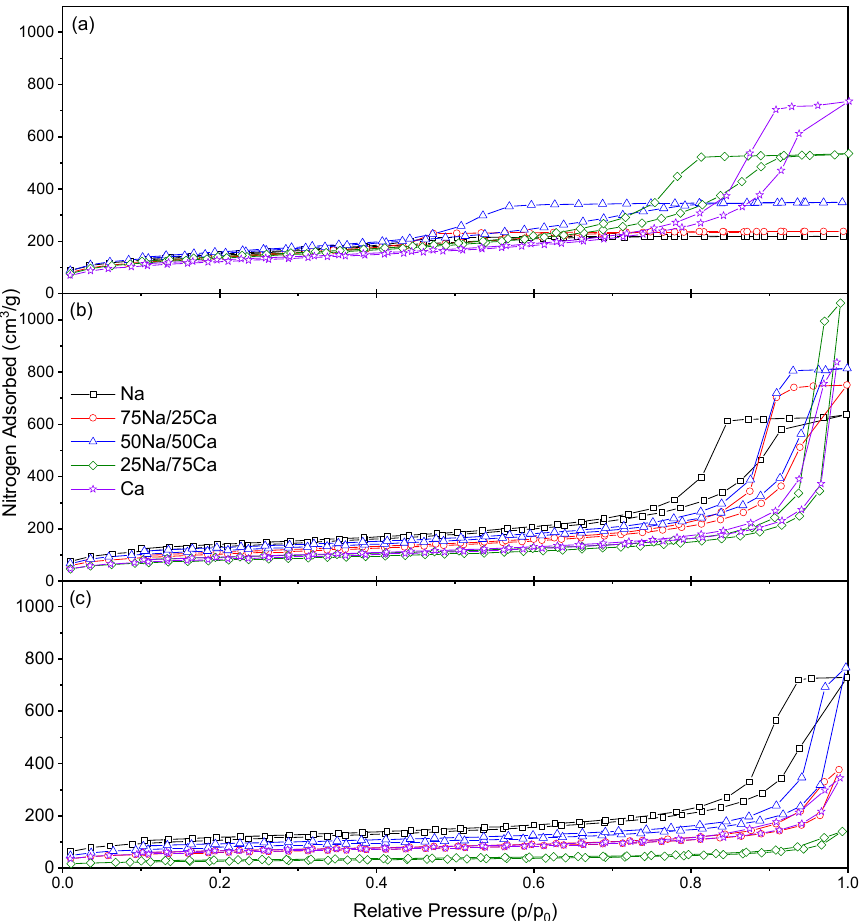
Figure 4. The sorption isotherms obtained for the resorcinol–formaldehyde xerogels produced using a 30% solids content and ( a ) R/C 100, ( b ) R/C 400, and ( c ) R/C 600. Comparison of xerogels obtained using either 100% Na or 100% Ca show that the differences observed for isotherms and pore size distributions are more marked at low R/C ratios, and such behaviour was observed in previous research [18]. Colloidal destabilisation due to a combination of a low solids content and the additional effects of Group II metal ions underpins the inability of Ca_600 20% and 75Ca/25Na_600 20% xerogels to form; this is similar to results often obtained for xerogels synthesised without metal cations (e.g., (NH 4 ) 2 CO 3 ). Here, the low concentration of Ca 2+ is a significant contributory factor in the failure to form a viable gel. This is not a factor for the Na + catalysed xerogels, as these tend to consist of closer-packed materials with narrower pore size distributions centred around a smaller pore diameter; hence, there is stabilisation from the closer proximity of the smaller clusters formed.